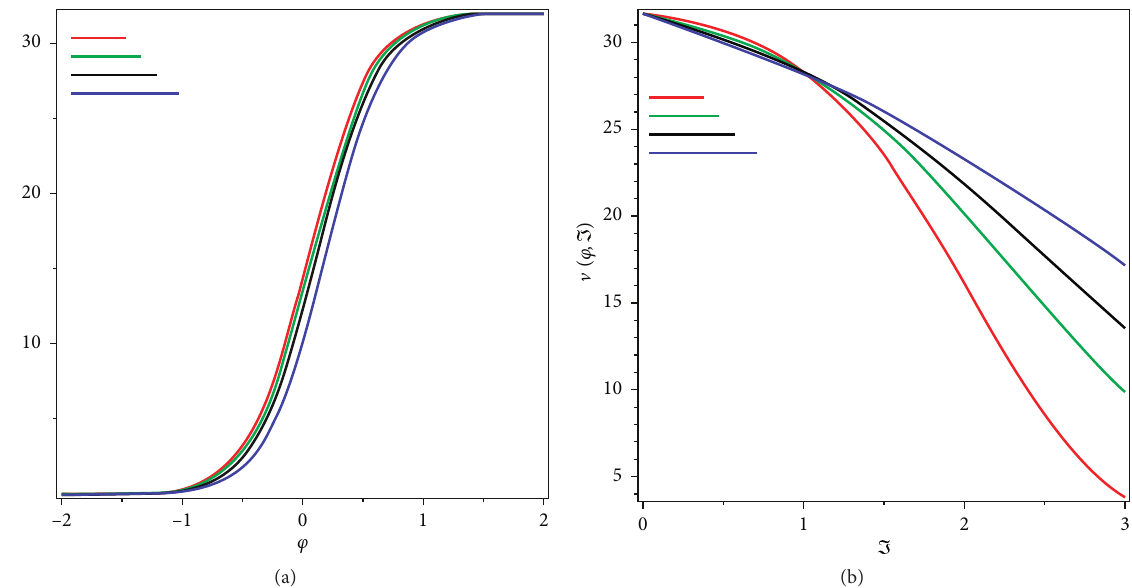
Figure 4: The different fractional-order solution with respect to the Caputo–Fabrizio operator of ] ( φ , I ) at β of Example